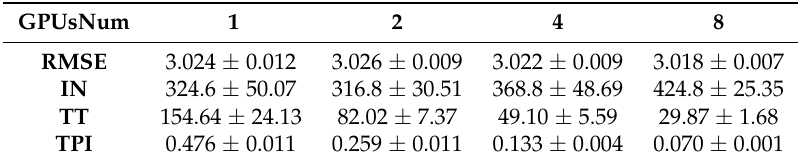
Table 10. Comparison of different GPUsNum in MG-ACOEE on the parallel performance for Cuprite data. IN, iteration number; IT, total time.